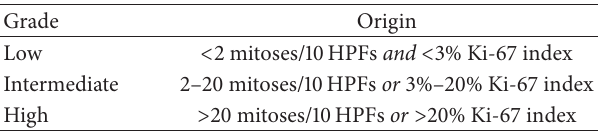
Table 1: World health organization classification of gastroen- teropancreatic neuroendocrine